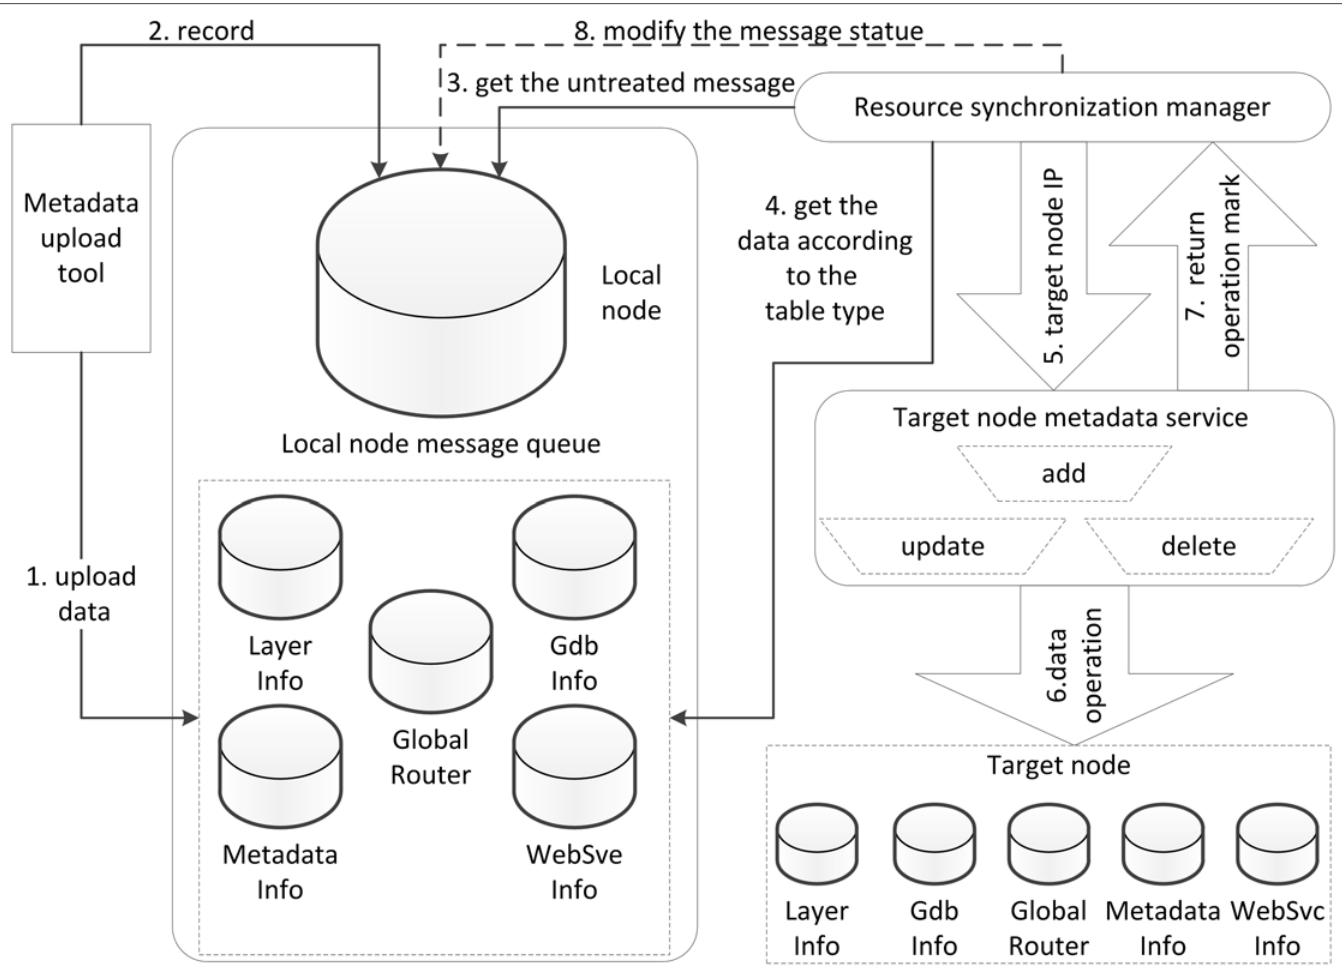
Fig 10. Resource synchronization